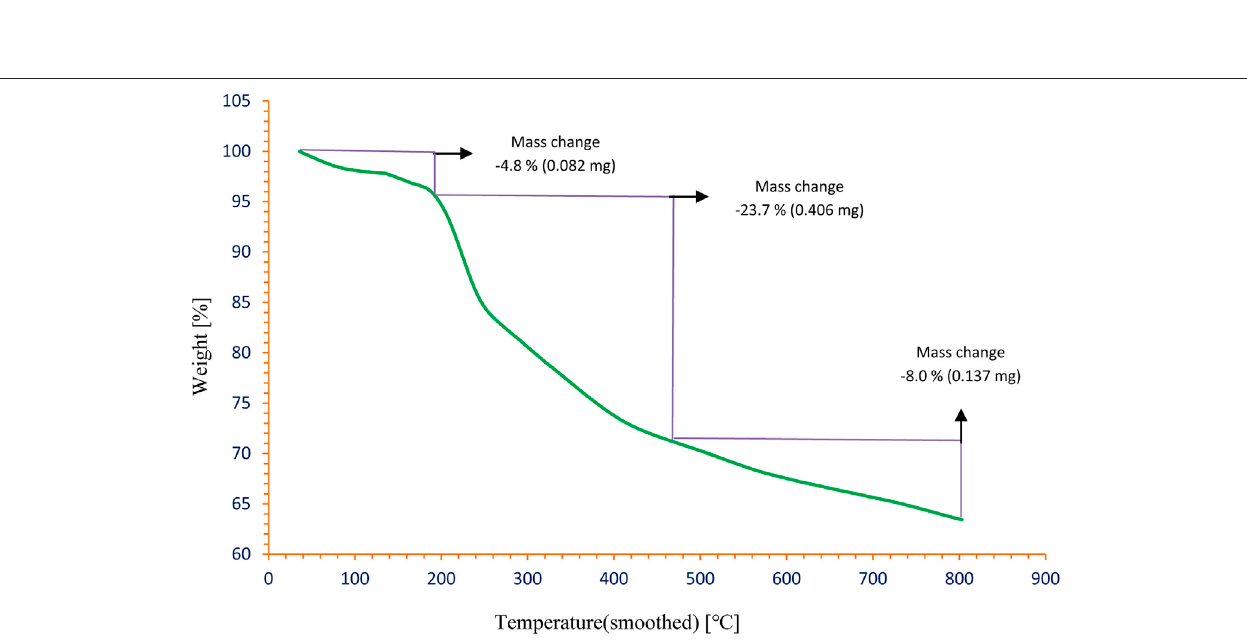
FIGURE 6 | The TGA curve of